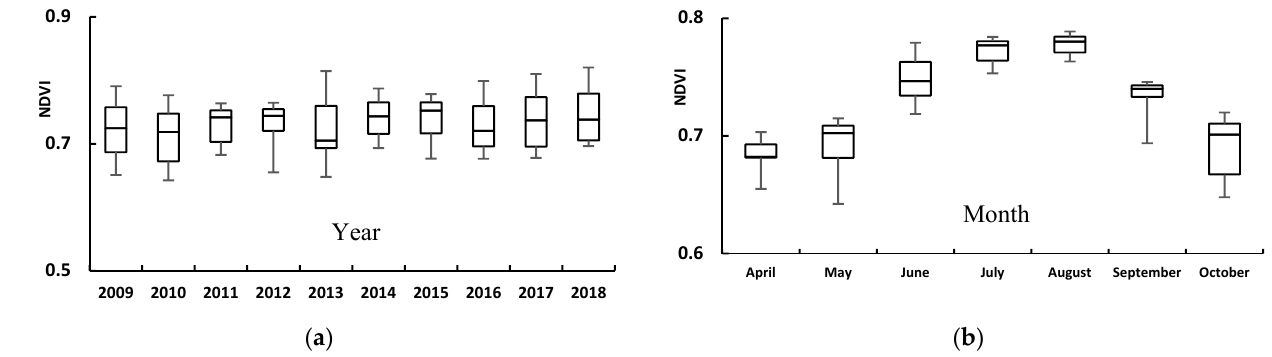
Figure 4. The mean of tea NDVI in growing season ( a ) and in the inter growing season ( b ).